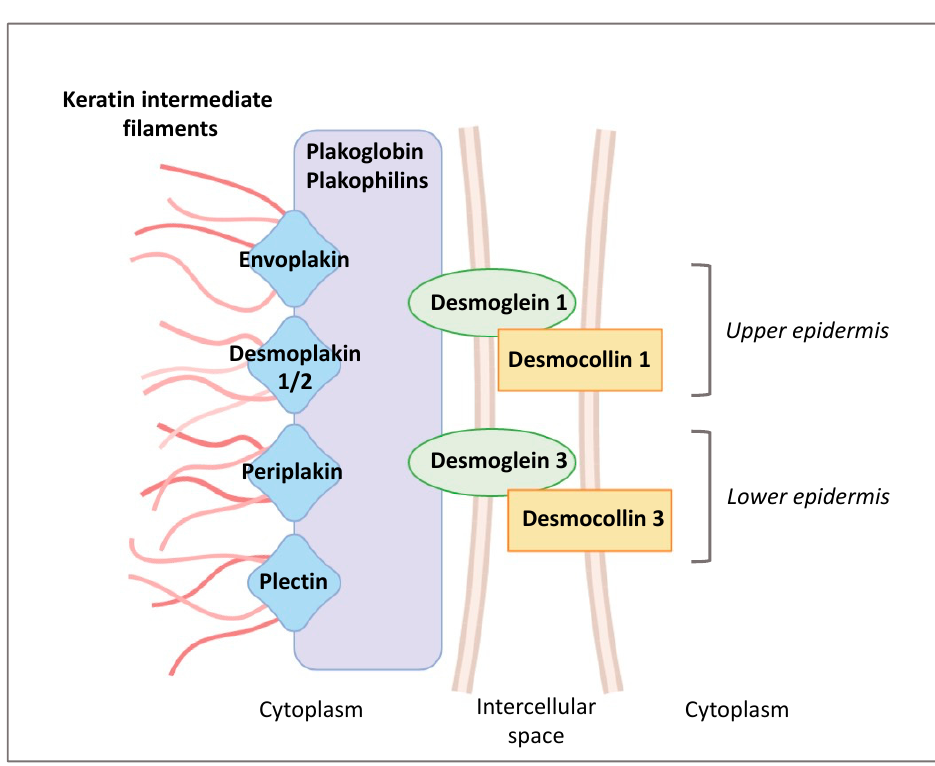
Figure 2. Changes in desmosome composition during keratinocyte differentiation.